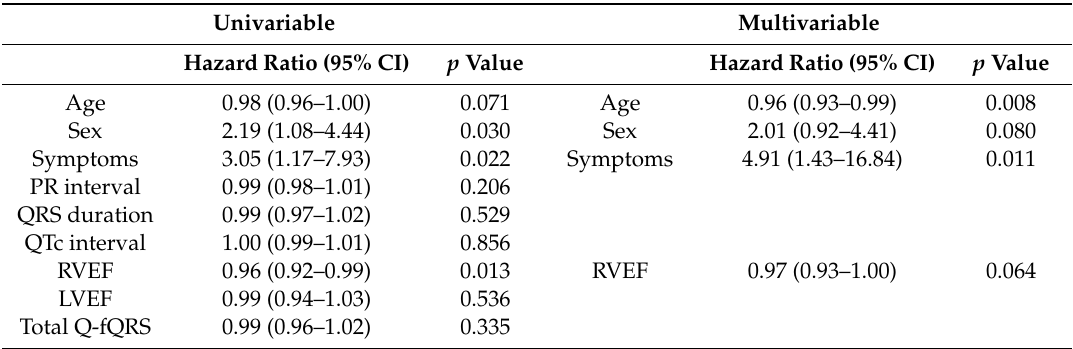
Table 3. Univariable and multivariate analysis of SVA risk in definite ACM patients without prior SVA. Univariable